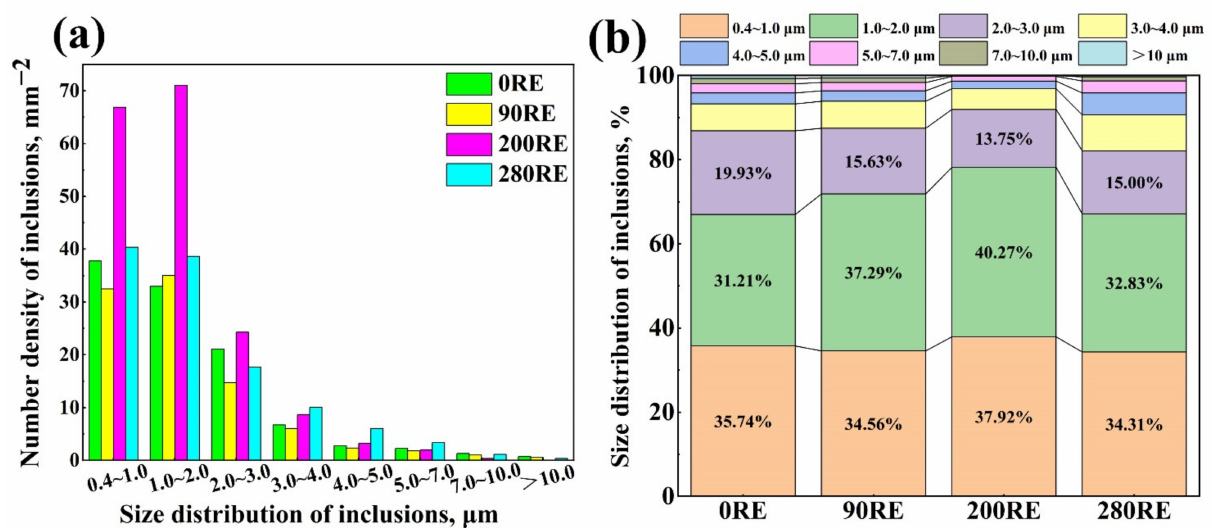
Figure 9. Comparison of the ( a ) number density and ( b ) size distribution of inclusions with different rare earth contents.